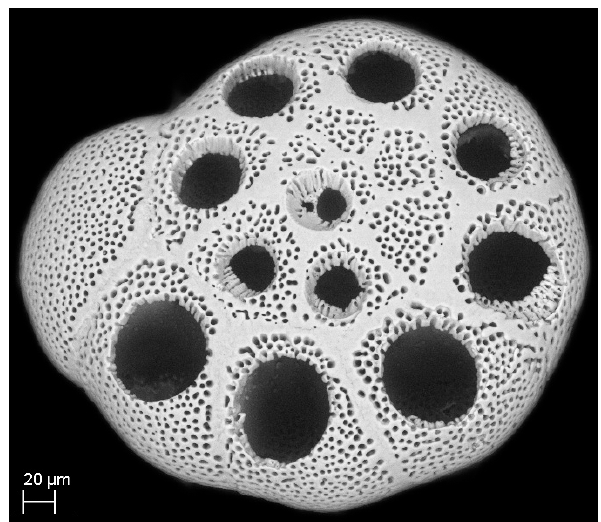
Figure 1. Scanning electron microscope (SEM) image of A. tepida specimen after laser ablation analysis of multiple chambers. Image taken at SCIAM: Service Commun d’Imageries et d’Analyses Mi- croscopiques, University of